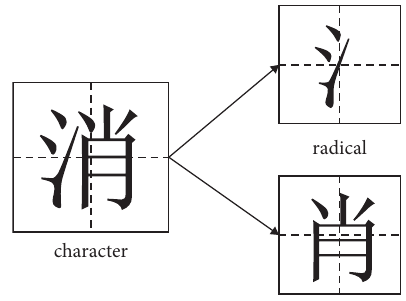
Figure 1: Decomposition of Chinese